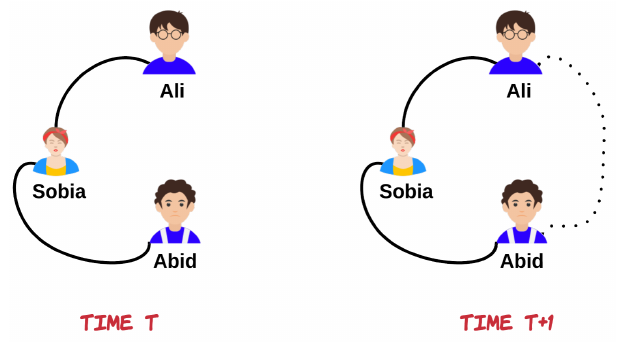
Figure 1. Example of Link